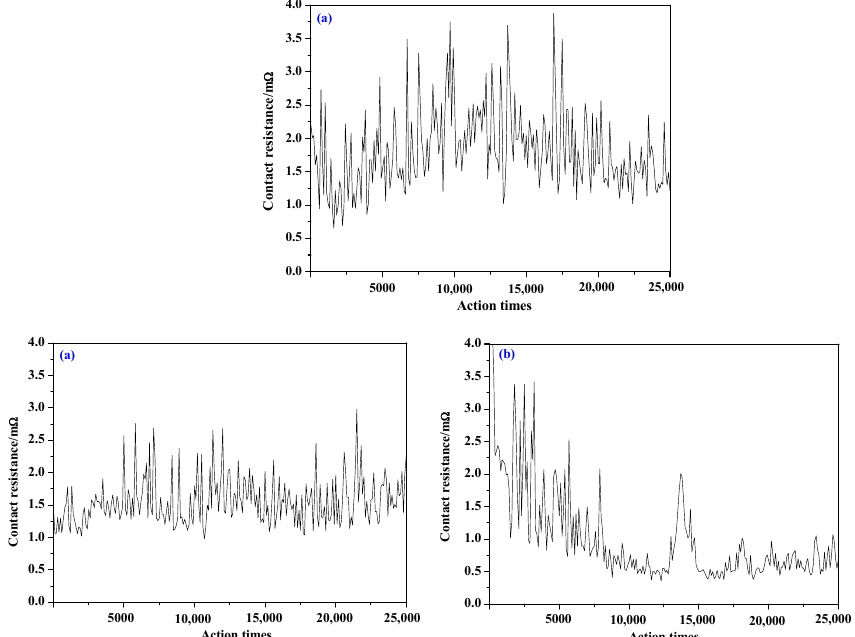
Figure 6. Contact resistance: ( a ) AgSnO 2 ; ( b ) AgSnO 2 -Cu; ( c ) AgSnO 2 -Cu-F.